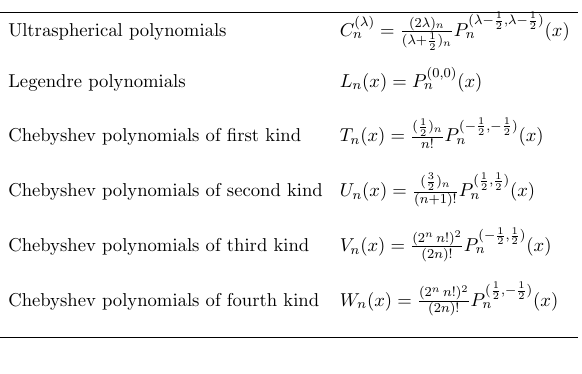
Table 1. Special cases of Jacobi